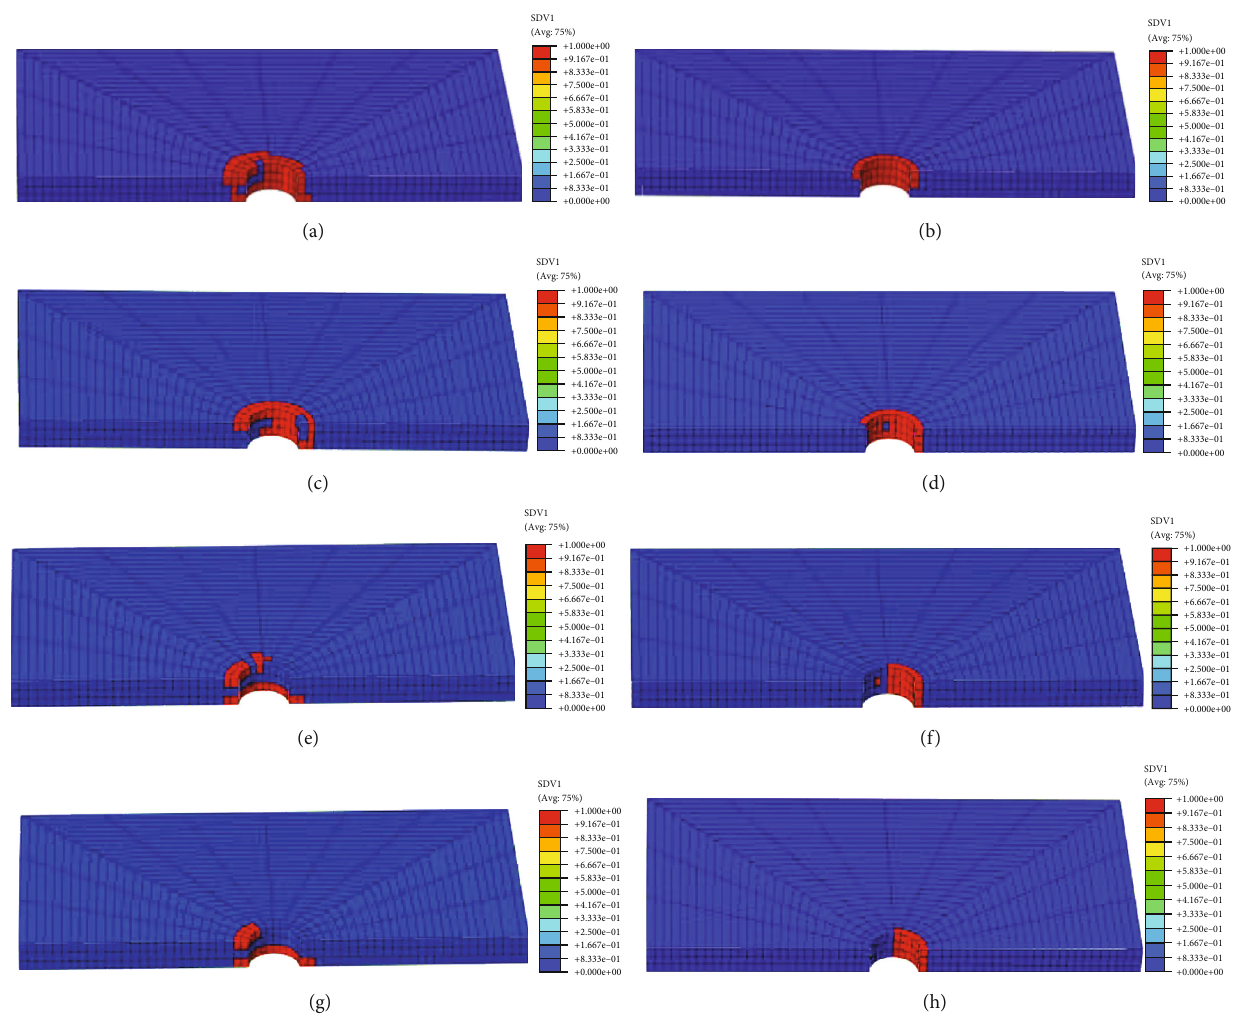
Figure 14: Final failure areas around fastener hole for the joint with various clearance levels at 25 ° C and 750 ° C (a) f = 0 %, T = 25 ° C. (b) f = 0 %, T = 750 ° C. (c) f = 0 : 4 %, T = 25 ° C. (d) f = 0 : 4 %, T = 750 ° C. (e) f = 0 : 8 % , T = 25 ° C. (f) f = 0 : 8 %, T = 750 ° C. (g) f = 1 .2%, T = 25 ° C; (h) f = 1 : 2 %, T = 750 °